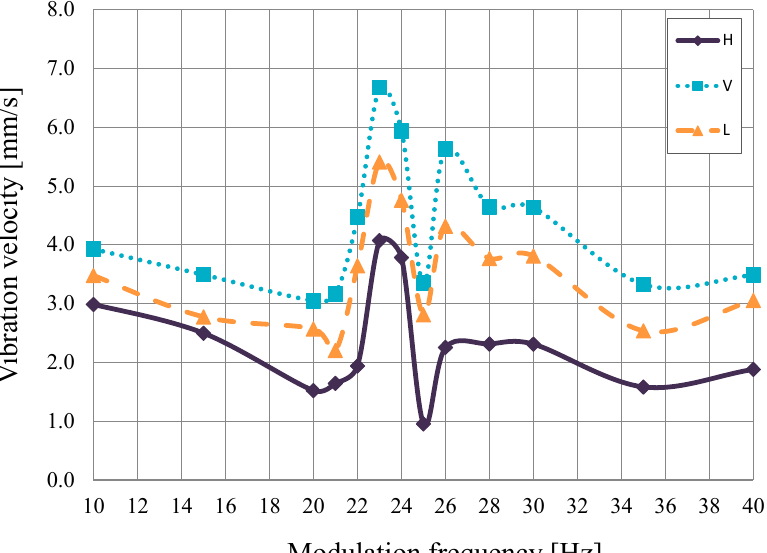
Figure 20. Measured broad-band vibration velocity for Case A in the horizontal (H), vertical (V) and longitudinal (L) directions versus the frequency of the voltage modulation.